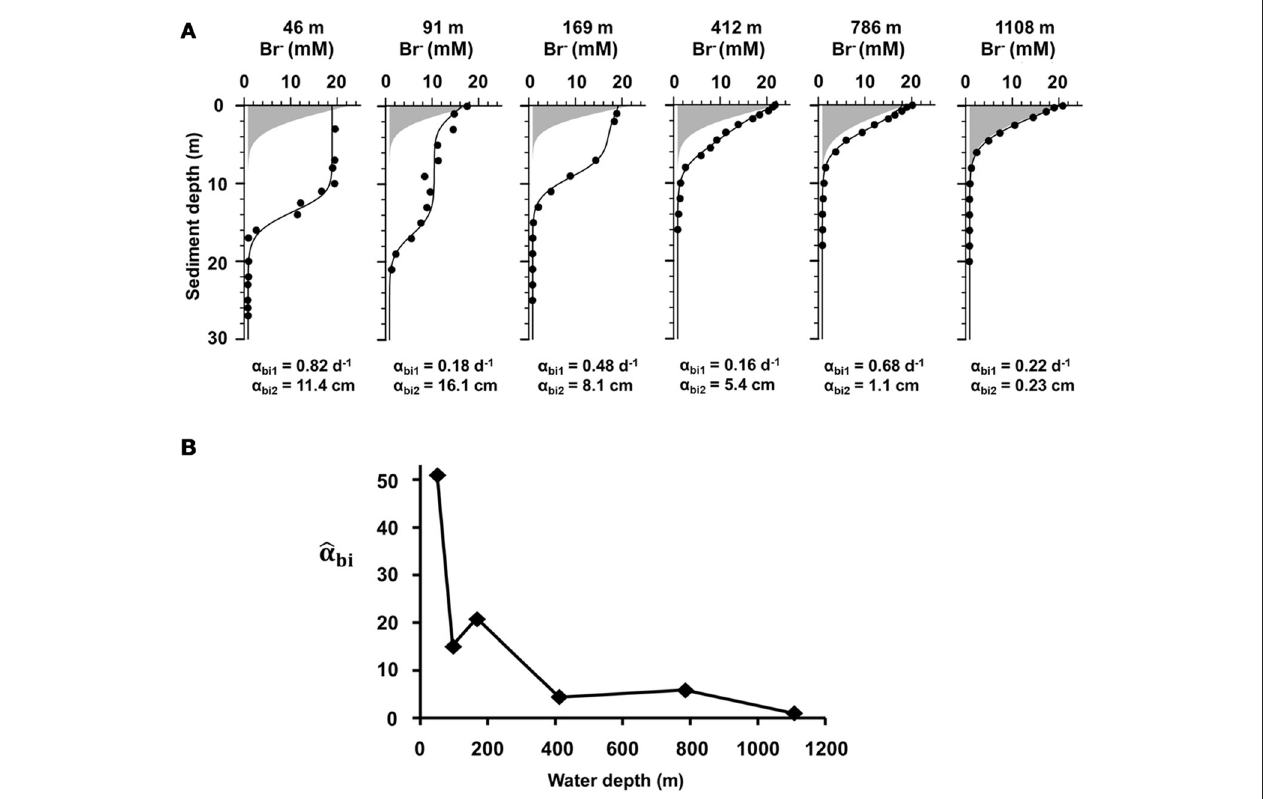
FIGURE 3 | (A) Sediment depth profiles of measured (symbols) and modeled (curves) bromide (Br − ) concentrations at the end of the bioirrigation experiments along the depth transect (47, 90, 169, 412, 786, and 1,108m). The gray area indicates the transport of Br − as expected by molecular diffusion only. The coefficients α bi1 (d − 1 ) and α bi2 (cm) represent the bioirrigation coefficient at the sediment surface and the parameter that controls the bioirrigation depth, respectively. (B) Depth-integrated bioirrigation coefficient (dimensionless) along the depth transect (m) normalized to the deepest